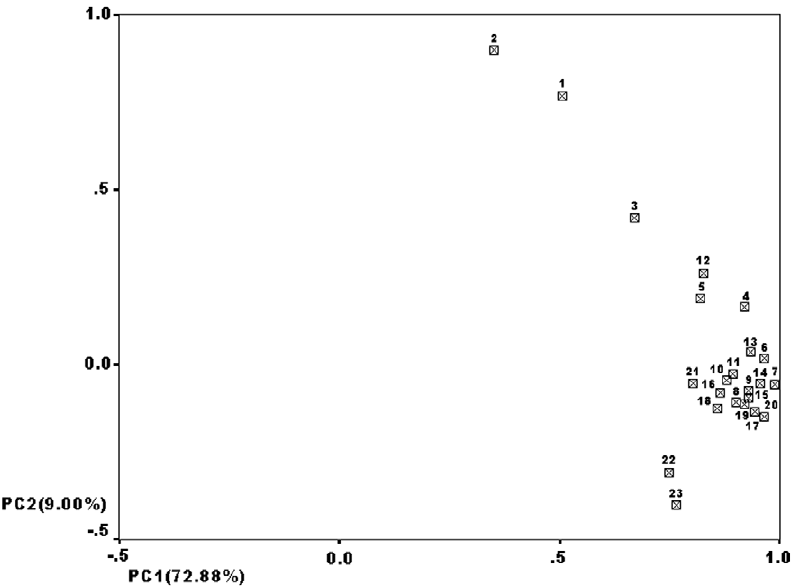
Figure 2. The two-dimensional maps of Y-SNP frequencies. In the principal-component plot, the smaller the distance between populations, the closer their relationship. In general 23 populations are divided into 4 clusters: the three EC high-risk populations, two Northern Han populations (labeled 5 and 6) and Hakka population, two Southern Han populations (labeled 22 and 23) and the rest of the Northern Han and Southern Han cluster, respectively. 1, Chaoshan EC high-risk population; 2, Fujian EC high-risk population; 3, Henan Taihang Mountain EC high-risk population; 4, Hebei Han; 5, Liaoning Han; 6, Xinjiang Han; 7, Shangdong Han; 8, Gansu Han; 9, Shanxi Han; 10, Neimeng Han; 11, Henan Han; 12, Hakka Han; 13, Hunan Han; 14, Hubei Han; 15, Guangzhou Han; 16, Zhejiang Han; 17, Jiangxi Han; 18, Shanghai Han; 19, Anhui Han; 20, Jiangsu Han; 21, Yunnan Han; 22, Guangxi Han; 23, Sichuan Han. 4–11 refer to Northern Han and 12–23 to Southern Han.